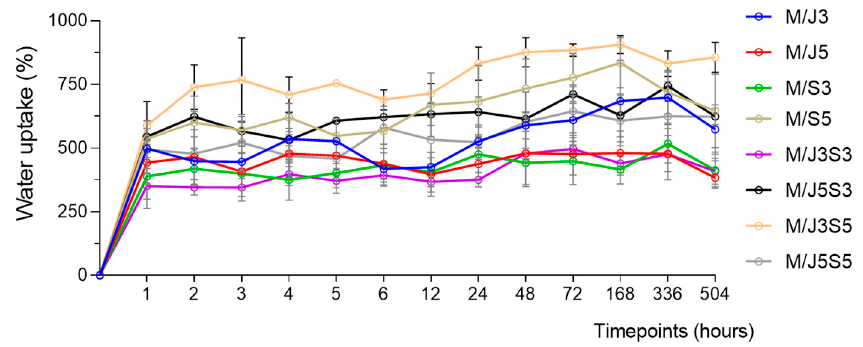
Figure 8. Assessment of the degree of swelling (measured as water uptake) in each membrane (M/J3 to M/J5S5) upon incubation in PBS solution for up to 21 days (504 h). Data are presented as mean ± standard error (n = 3).